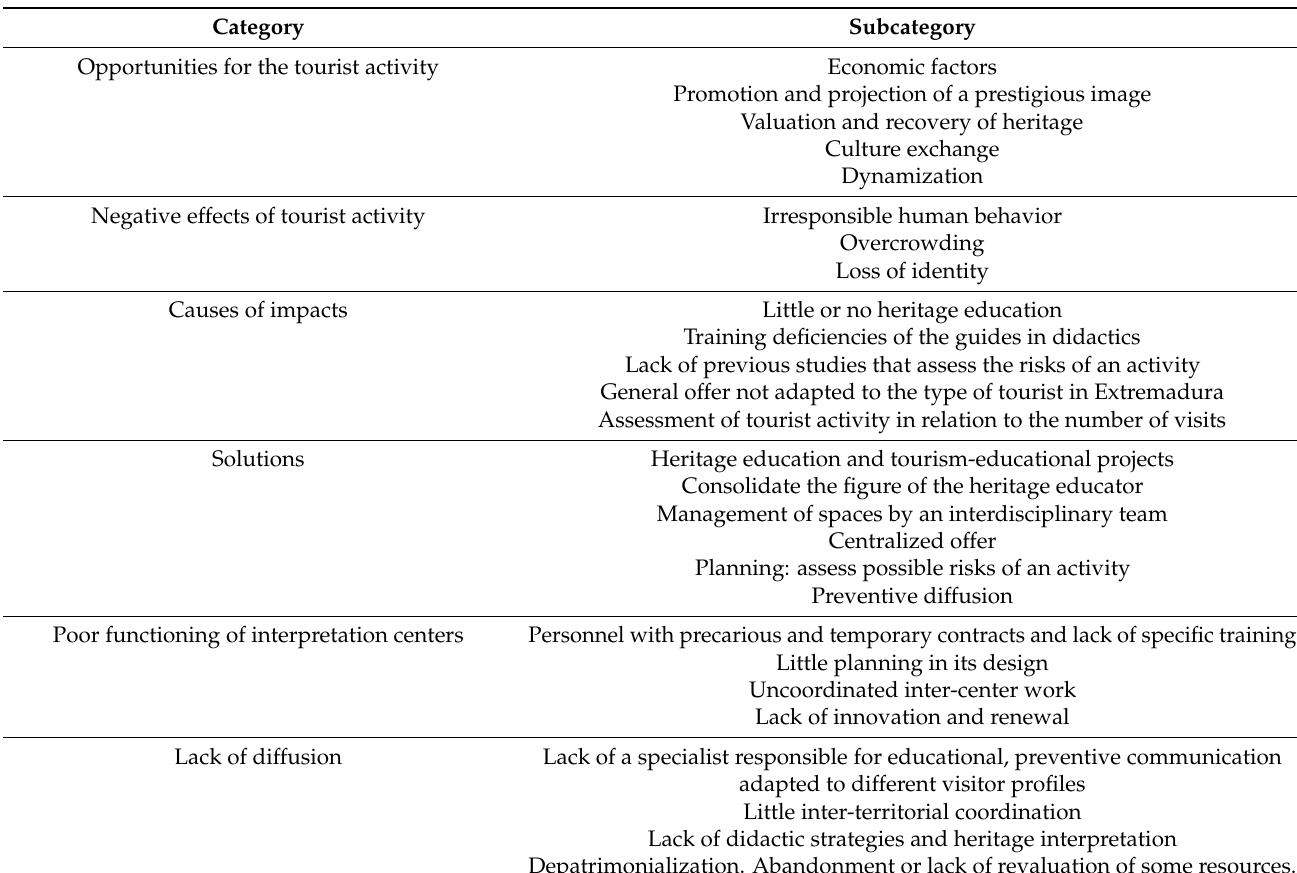
Table 9. Results of in-depth